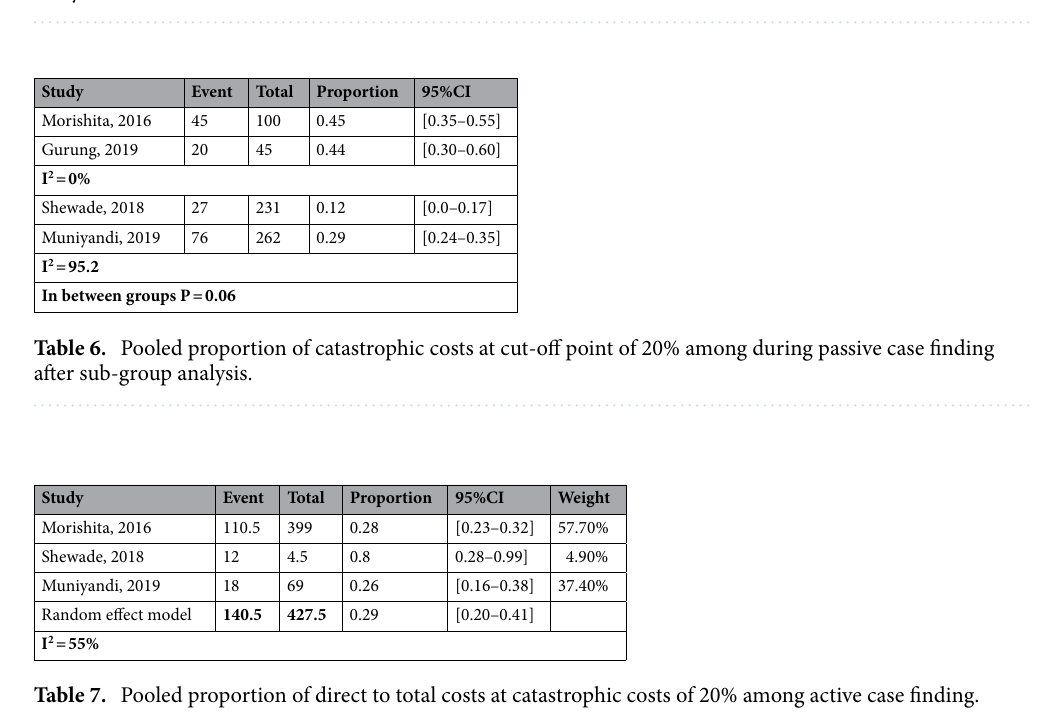
Table 5. Pooled proportion of catastrophic costs at 20% among during active case finding after sub-group analysis.